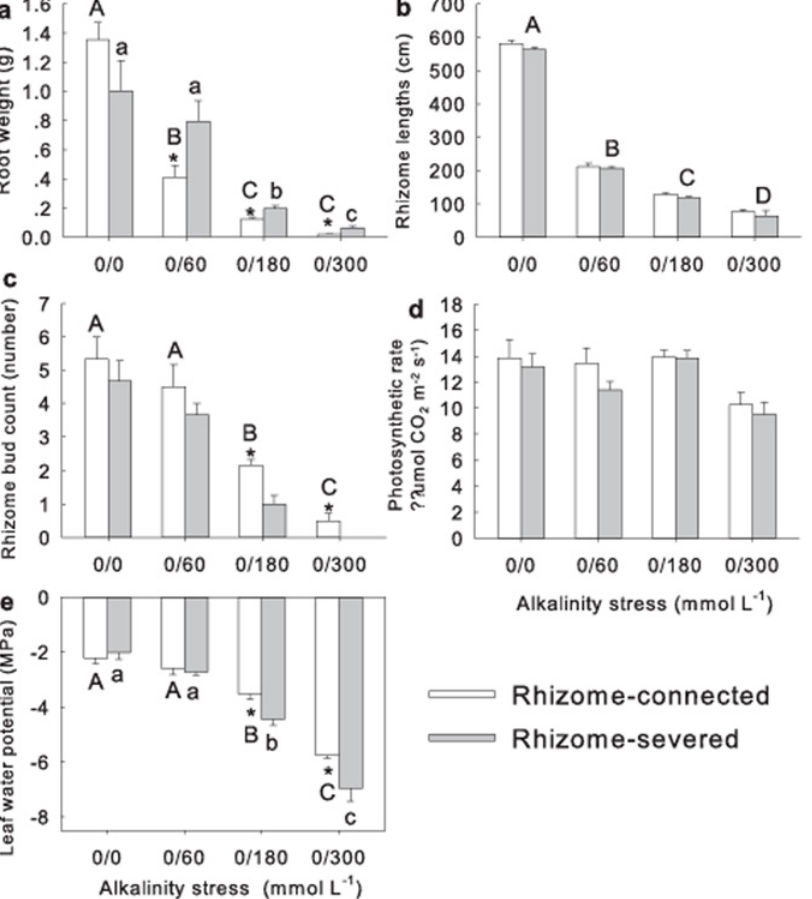
Fig 2. Effects of alkalinity stress and rhizome connection on a) root weight, b) rhizome length, c) bud number, d) photosynthetic rate and e) water potential of subsequent ramets. Bar groups with different capital letters indicate significant differences ( P < 0.05) between the four levels of alkalinity in the rhizome- connected treatment. Bar groups with different lowercase letters indicate significant differences ( P < 0.05) between the four levels of alkalinity in the rhizome-severed treatment. Asterisks indicate significant differences ( P < 0.05) between rhizome-connected and rhizome-severed treatments.